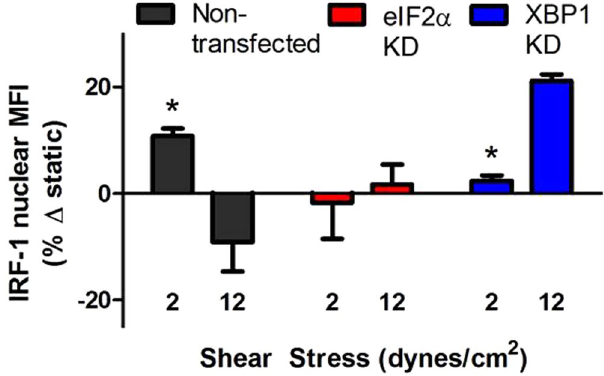
Figure 6. Shear regulation of IRF-1 activation is signaled by ER stress. HAEC transfected with shRNA against eIF2 α or XBP1 were treated with TNF α and SS for 2 hrs and nuclear IRF-1 was quantified by immunofluorescence microscopy and compared to control. Values are mean ± SE, n = 3–4, * P < 0.05 comparing low to high SS within group.